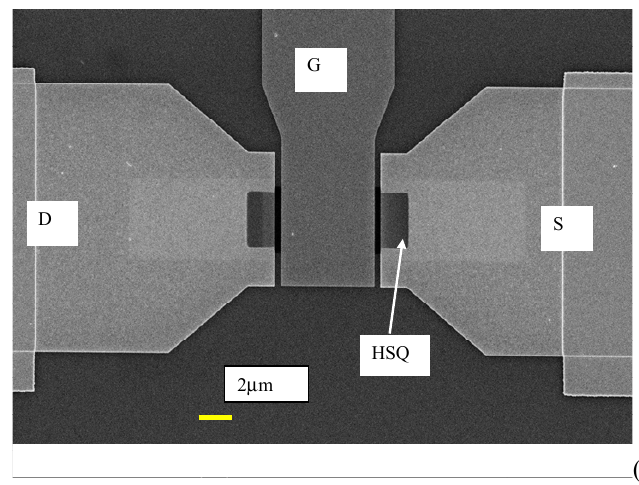
Figure 1. ( a ) Optical image, and ( b ) SEM image of the HfZrO/Al 2 O 3 /Si graphene field-effect transistor (FET).